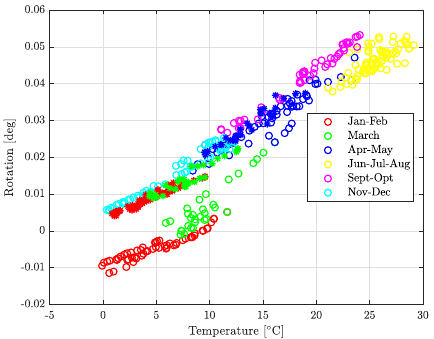
Figure 8. T2 daily average trend (2021–2022) vs. temperature.